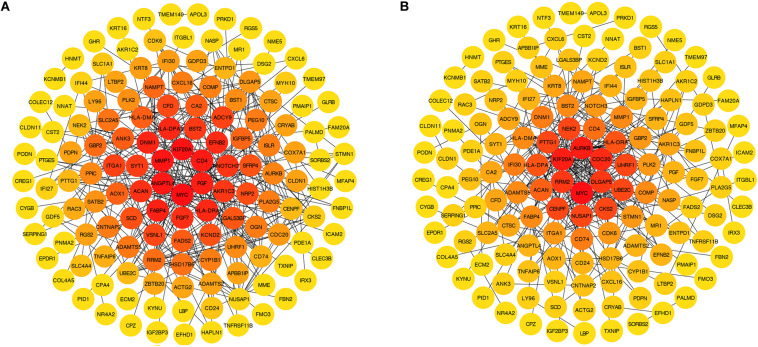
DEGs with a P-value < 0.001 ranked by betweenness (A) and degree (B) methods using cytoHubba in Cytoscape. The change of color from orange red to yellow represents the change of centrality score from high to low.